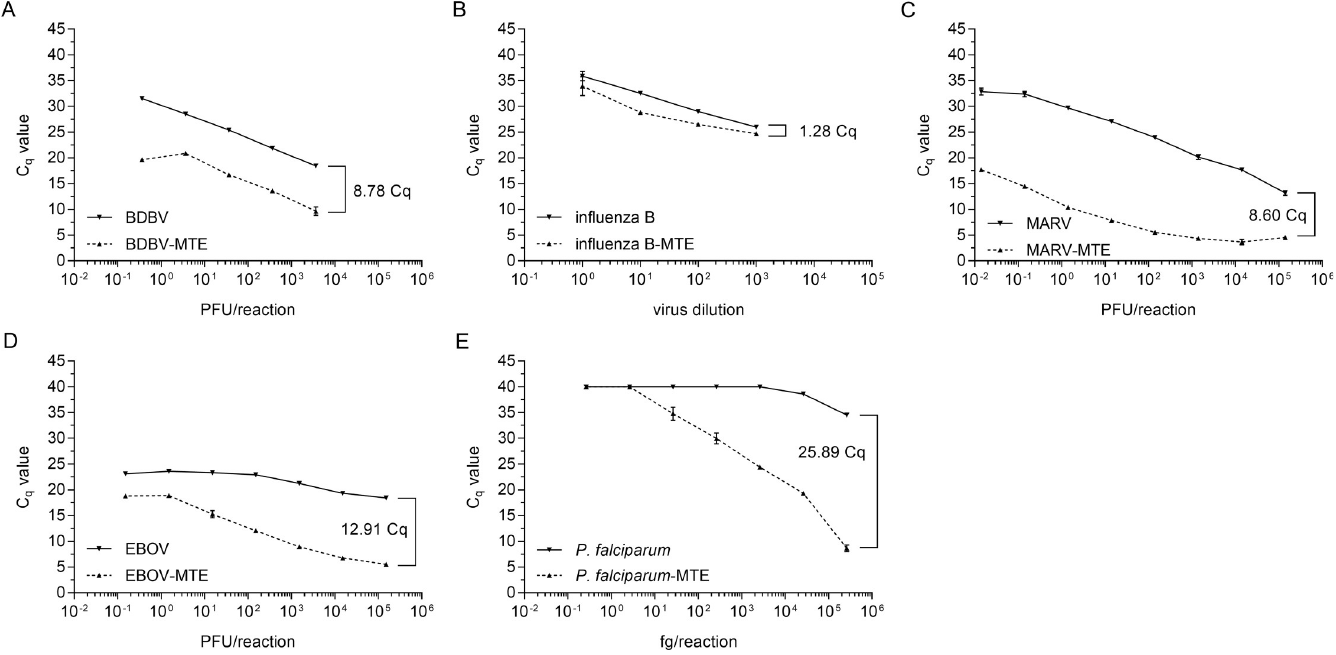
Fig 2. Preliminary LOD determination by the NanoString broad pathogen detection panel. BDBV (A), influenza B virus (B), MARV (C), EBOV (D), and P . falciparum (E) nucleic acid were serially diluted and assayed with and without MTE in triplicate. Arrows indicate the lowest concentration where all three replicates were positive (the preliminary LOD). Error bars show the range of the two samples. Influenza B virus was undetectable without amplification.